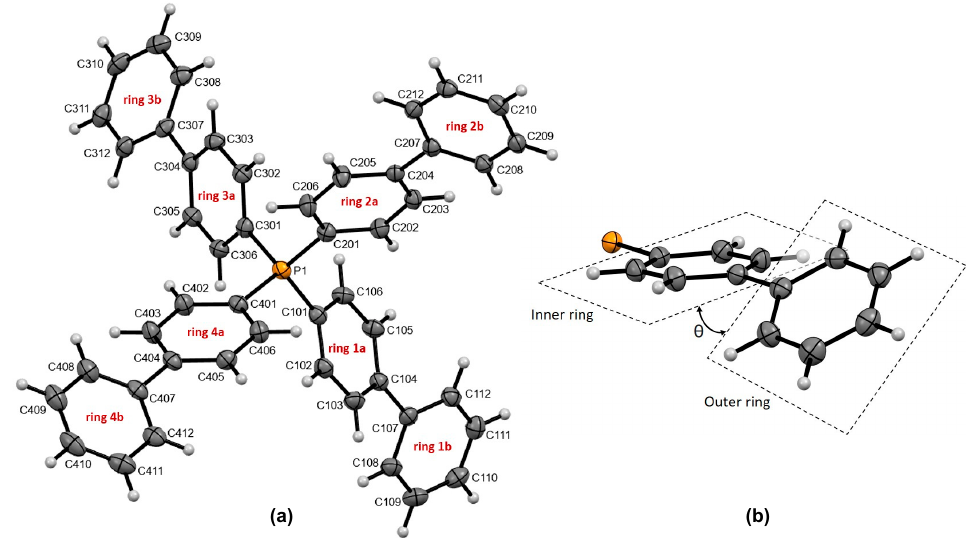
Figure 1. ( a ) ORTEP [29] view of the molecular structure of tetra-biphenyl phosphonium cation for 1 . Ellipsoids are drawn at 50% probability level. Salt 2 has similar cation structure and follows the same numbering scheme as in 1 . ( b ) The interplanar angle between inner and outer (closer to or further from the phosphorus centre, respectively) aromatic ring of a single biphenyl unit.